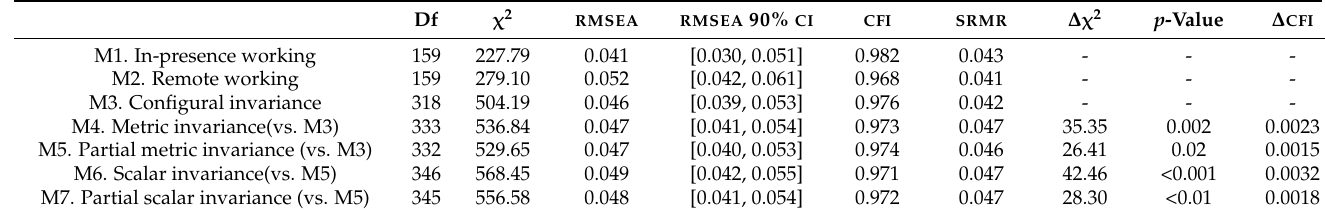
Table 7. SAPH@W invariance for working condition: model